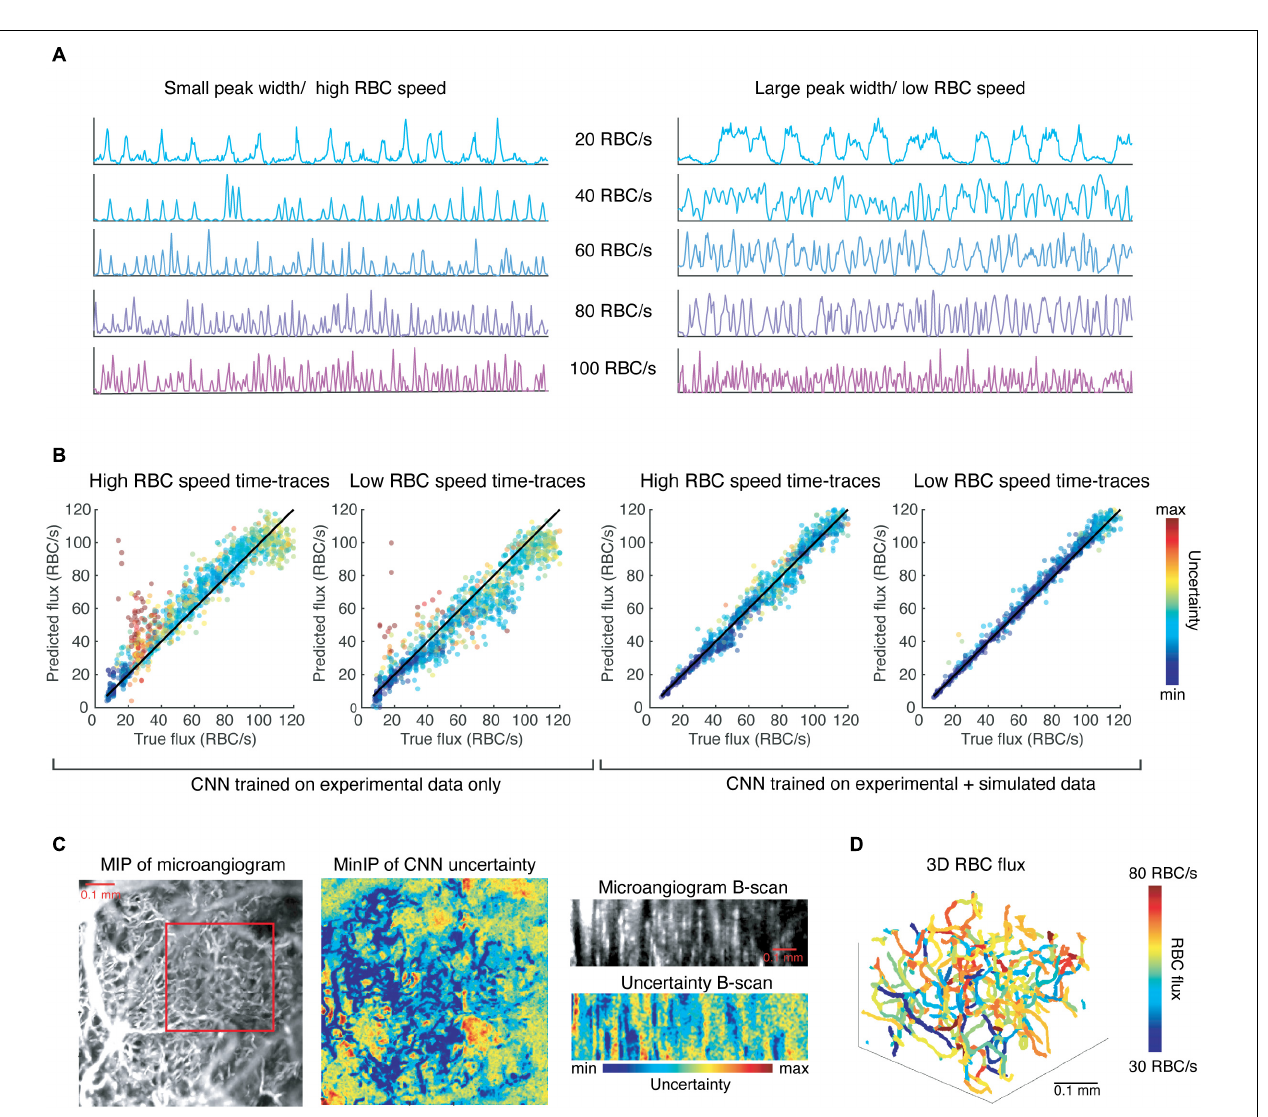
FIGURE 4 | Convolutional neural network trained on simulated data is more robust to different RBC speeds (peak widths) than the CNN trained only on experimental data and can be utilized to extract RBC flux in a network of capillaries. (A) Simulated time-traces with the smallest (left) and largest (right) mean peak widths that were observed experimentally. (B) Results of the CNNs trained on experimental data and simulated data, respectively, with the input are time-traces like those shown in (A) . (C) The CNN predicts flux values with low uncertainty for voxels corresponding to capillaries. (D) The 3D RBC flux of the capillaries shown in the red square in (C)